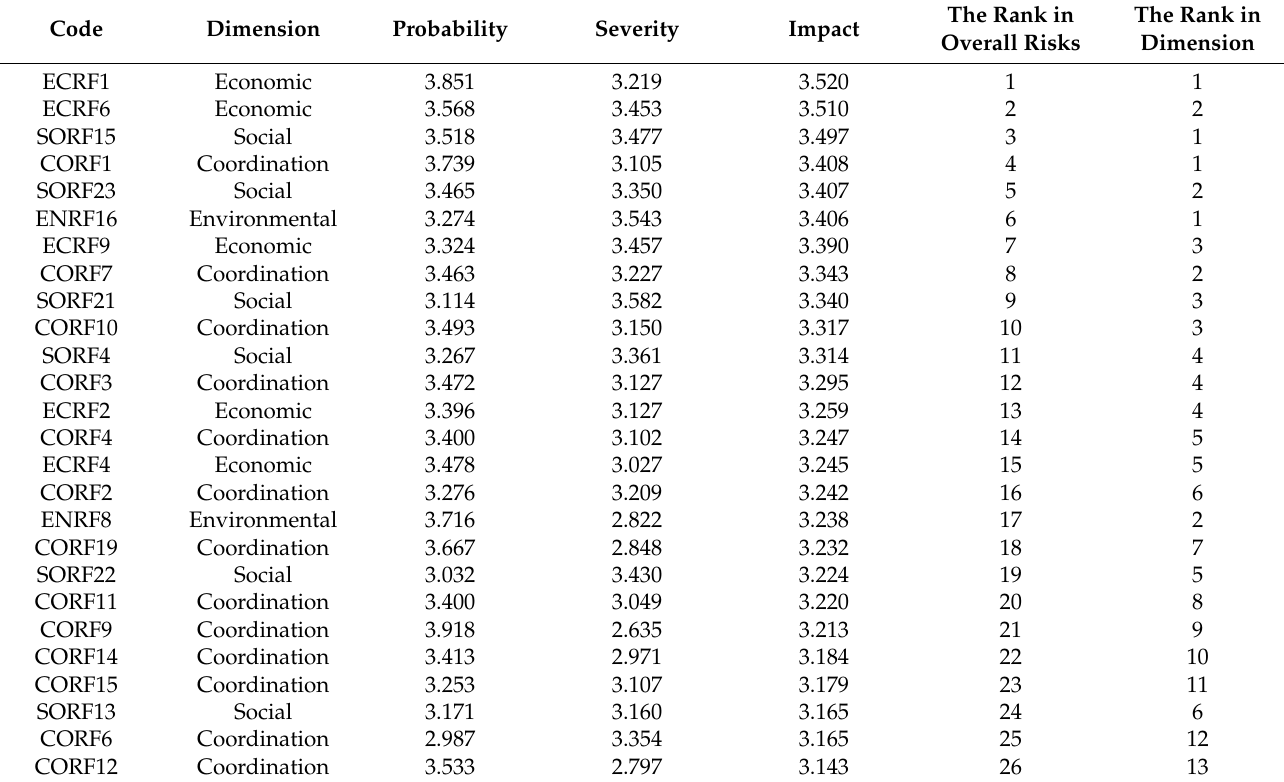
Table 5. The rank of risk